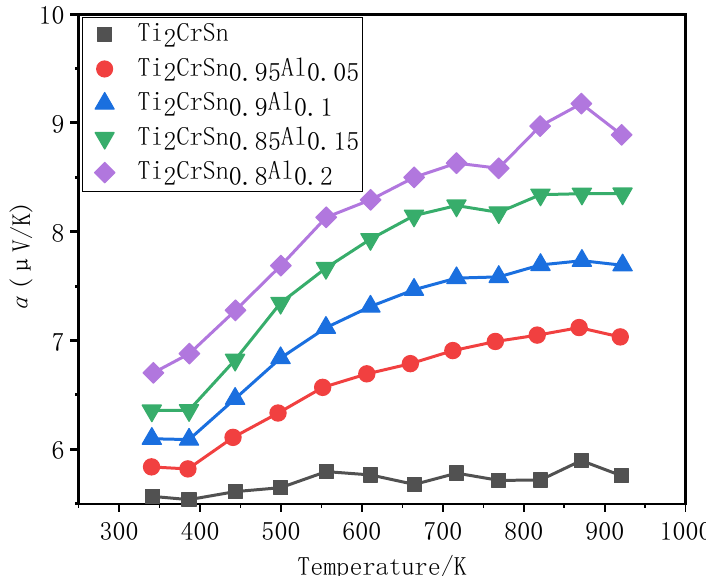
Figure 3. Curves of the Seebeck coefficient with respect to temperature for the Ti 2 CrSn 1 − x Al x (x = 0, 0.05, 0.1, 0.15, 0.2) alloy.